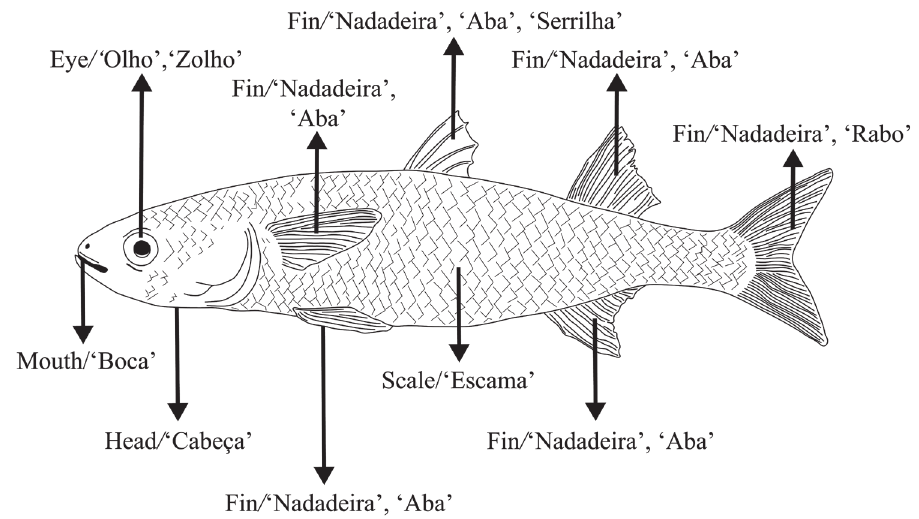
FIGURE 2 | Morphological features of a gray mullet (Mugilidae), showing the terminology used by the fishers of the Caeté-Taperaçu Marine Extractive Reserve in Bragança, Pará,